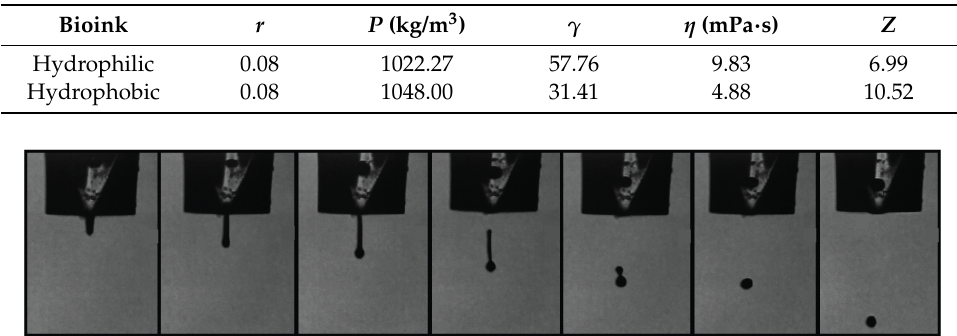
Table 1. Physical properties and Z value of formulated bioinks.